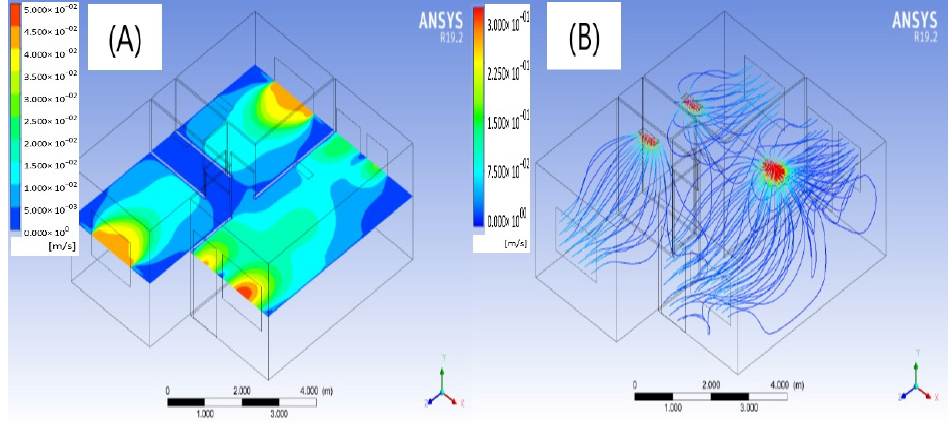
Figure 9. Velocity magnitude in the z–x plane for a rectangular channel ( A ) and the flow lines for a rectangular channel ( B ).